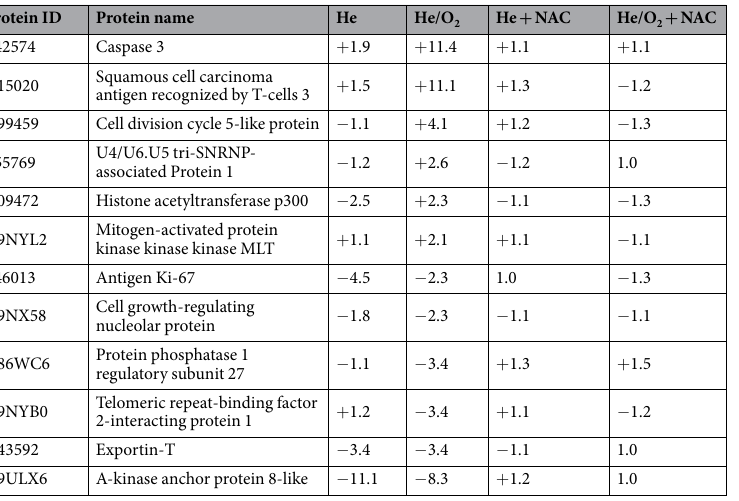
Table 1. THP-1 killing by plasma was accompanied by alterations in protein expression involved in apoptosis and growth retardation. In presence of NAC (2 mM) or vehicle control, THP-1 cells were either left untreated or exposed to either He or He/O 2 plasma. Four hours after treatment, cells were lysed, and proteins were analysed with a proteomic approach using LC/MS. Six representative positively and negatively regulated proteins with at least 2-fold regulation are given in the table for all four treatment regimes. Data sorting is shown in a descending manner for He/O 2 plasma